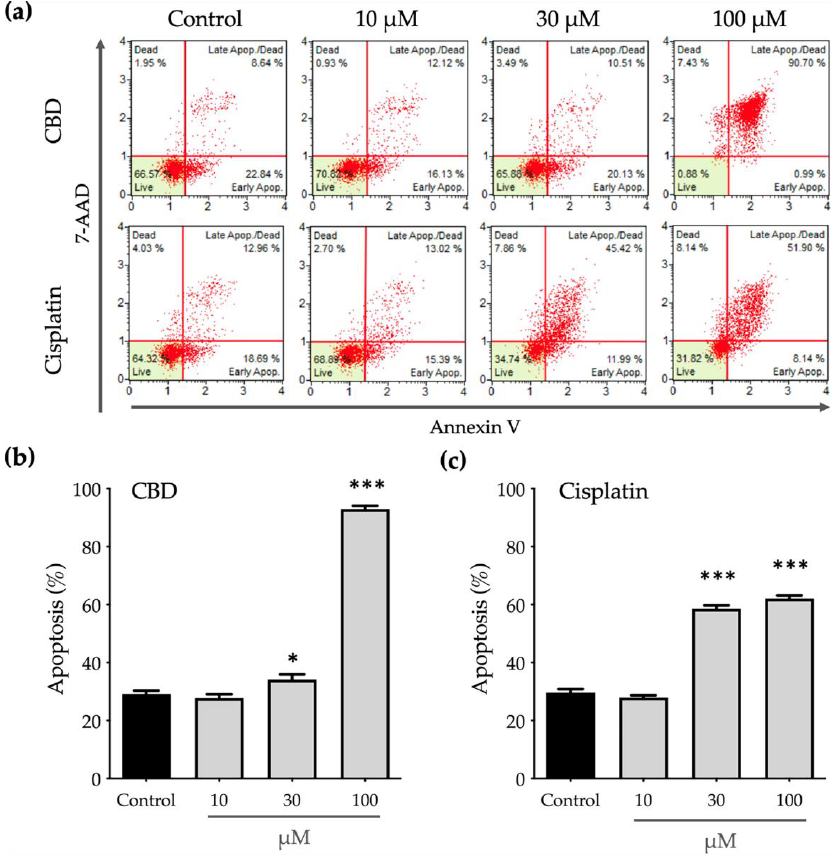
Figure 2. Apoptotic effect of CBD and cisplatin on OEC-M1 cells: ( a ) Apoptosis of OEC-M1 cells following treatment with CBD and cisplatin at 10, 30, and 100 μM was determined using annexin V/7-AAD staining assays. The cell populations with annexin V/PI double negative and annexin V – positive and annexin V/PI double positive are indicated as live and apoptotic cells, respectively. The statistic histogram shows the changes in the apoptotic populations after treatment with ( b ) CBD and ( c ) cisplatin for 24 h. All data are represented as mean ± standard error mean (SEM) for at least three independent experiments of (A). * p < 0.05; *** p < 0.001 as compared with the control group.